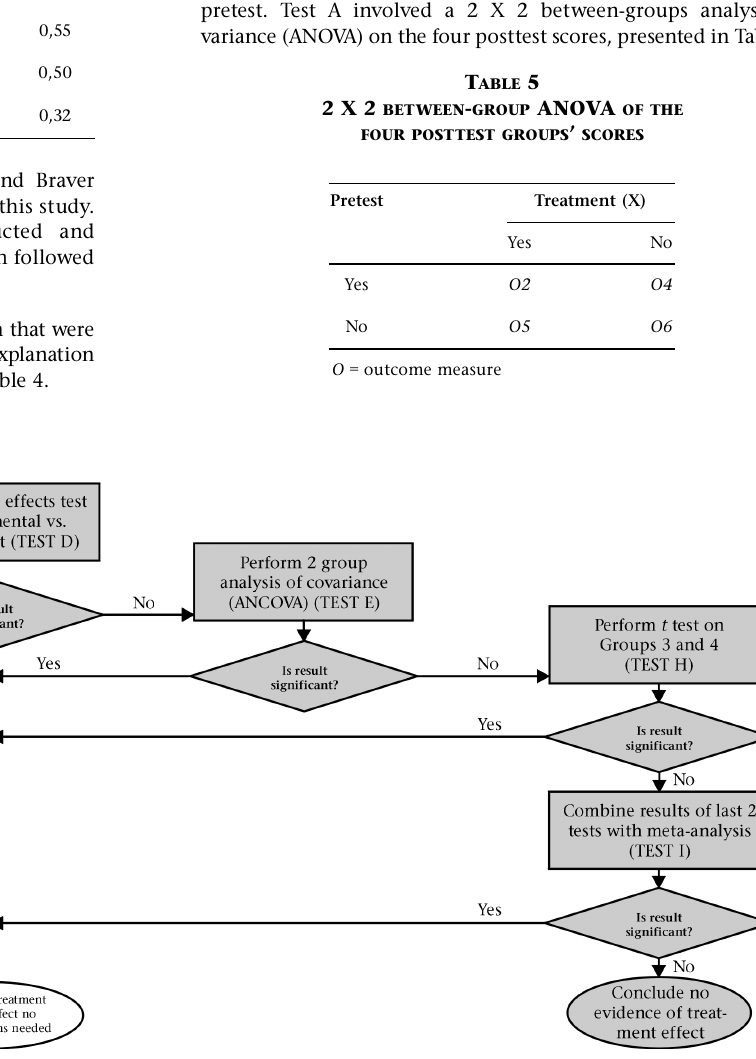
Figure 2: Flowchart of tests conducted and conclusions made to achieve results (Braver & Braver, 1988,